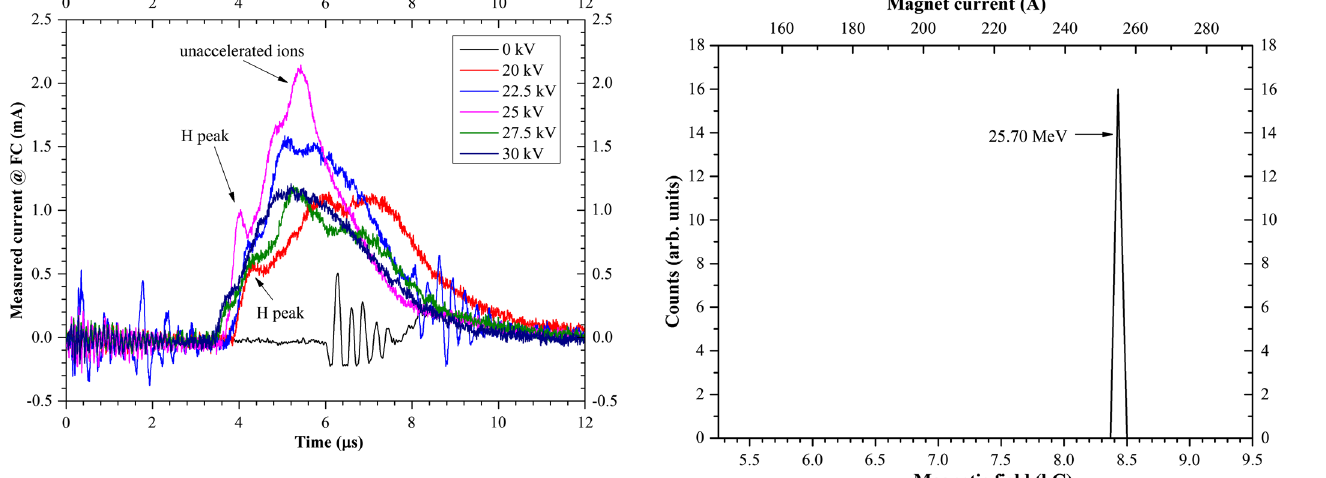
FIG. 14. Measured beam signals with respect to extraction voltages (plasma input position: − 12 mm, rf power: 27 kW).